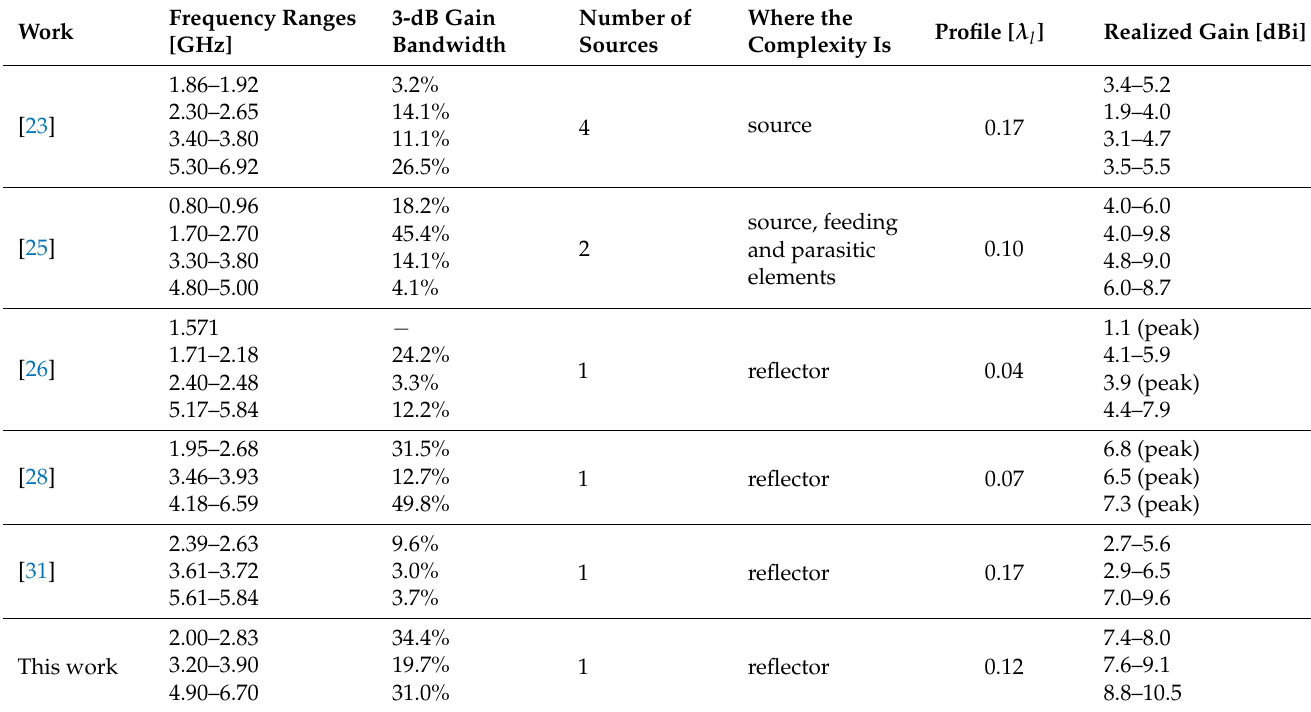
Table 3. Comparison between prominent multiband antenna